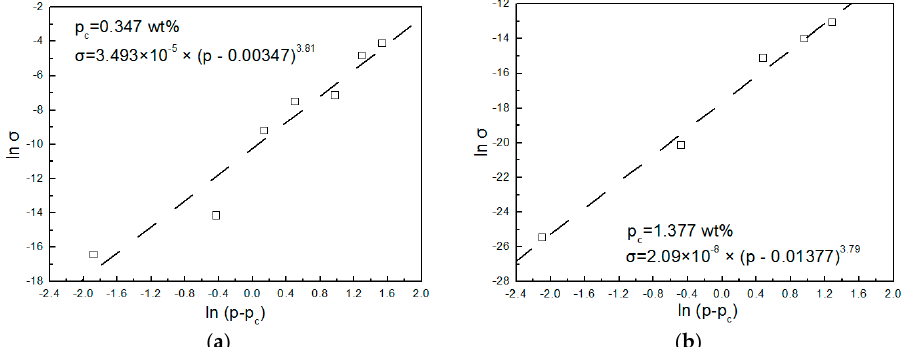
Figure 6. Best linear curve fitting for PPS/PEEK/MWCNT nanocomposites with different MWCNT